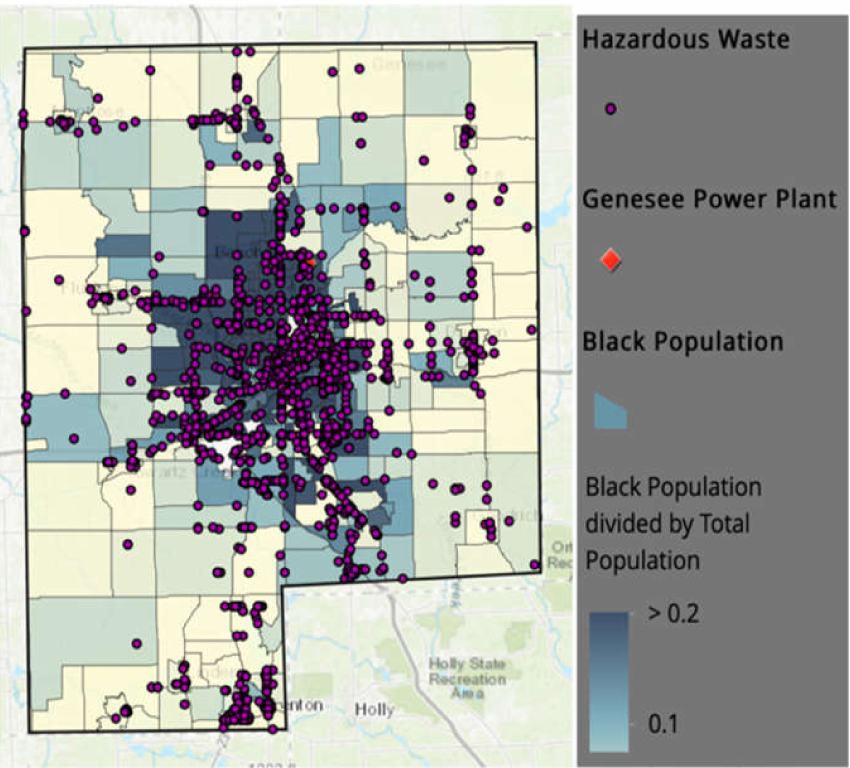
Figure 9. The central and northern parts of Flint are home to predominantly African American populations as well as a number of hazardous waste